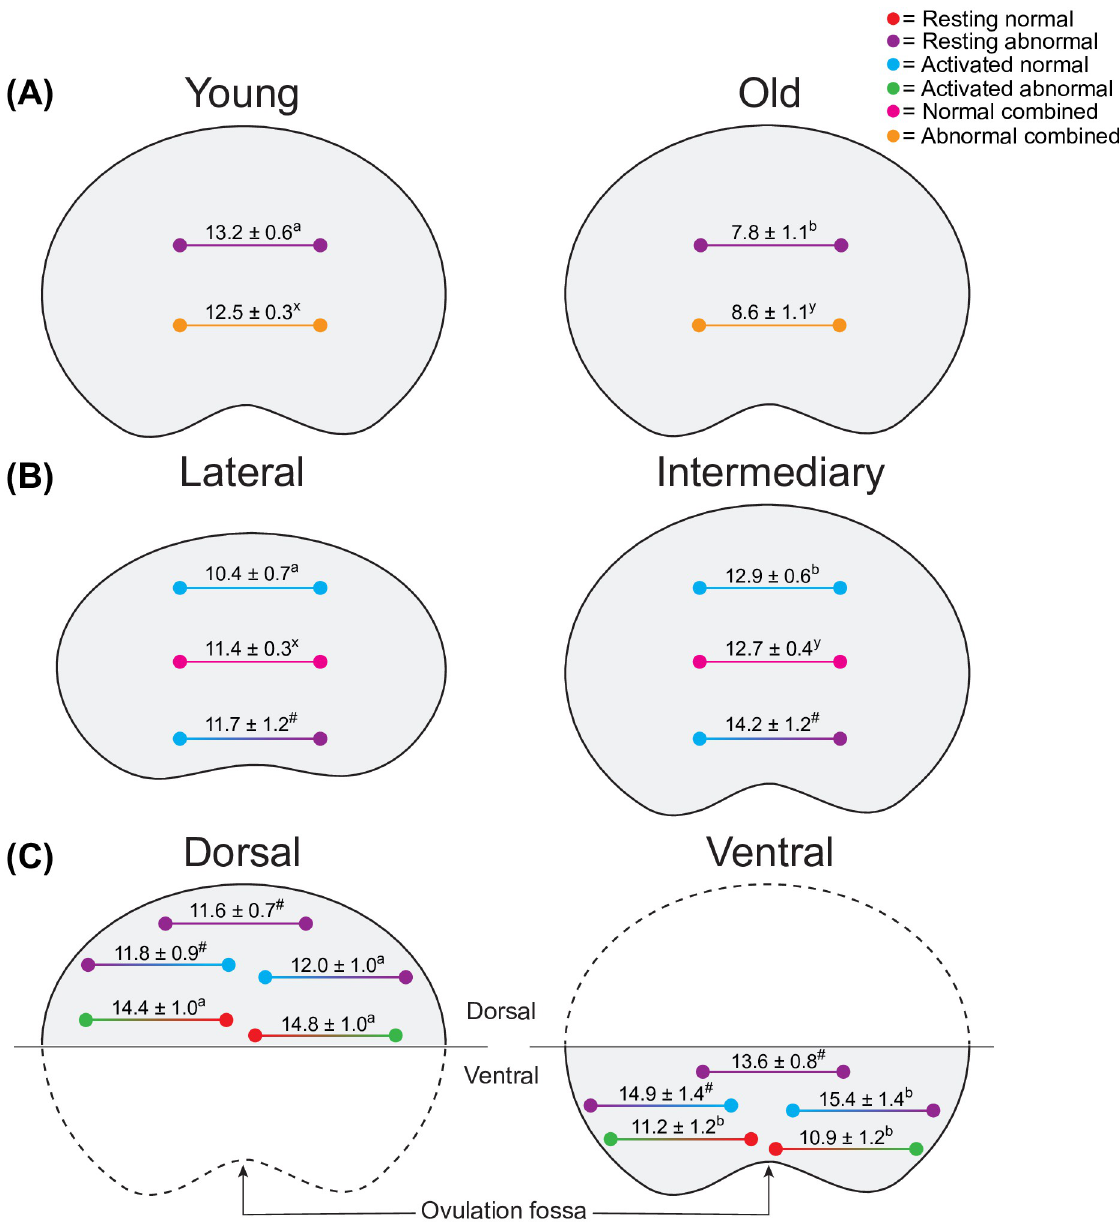
Fig 7. Illustration of the observed significant differences in mean distance ( ± SEM) between pairs of neighboring follicles of particular morphology and developmental stage considering (A) mare age groups, (B) ovarian portions, and (C) ovarian regions. a,b Within the same follicular morphology and developmental stage between pairs of neighboring follicles, values without a common superscript differed. x,y Within the same follicular morphology when developmental stages were combined between pairs of neighboring follicles, values without a common superscript differed. # Indicates tendency ( P = 0.06–0.07) within the same follicular morphology and developmental stage between pairs of neighboring follicles. For the shown data, no differences ( P > 0.05) were found within each age group, ovarian portion, or ovarian region. All data were analyzed using the Kruskal-Wallis test followed by the Dunn’s test. Comb.,